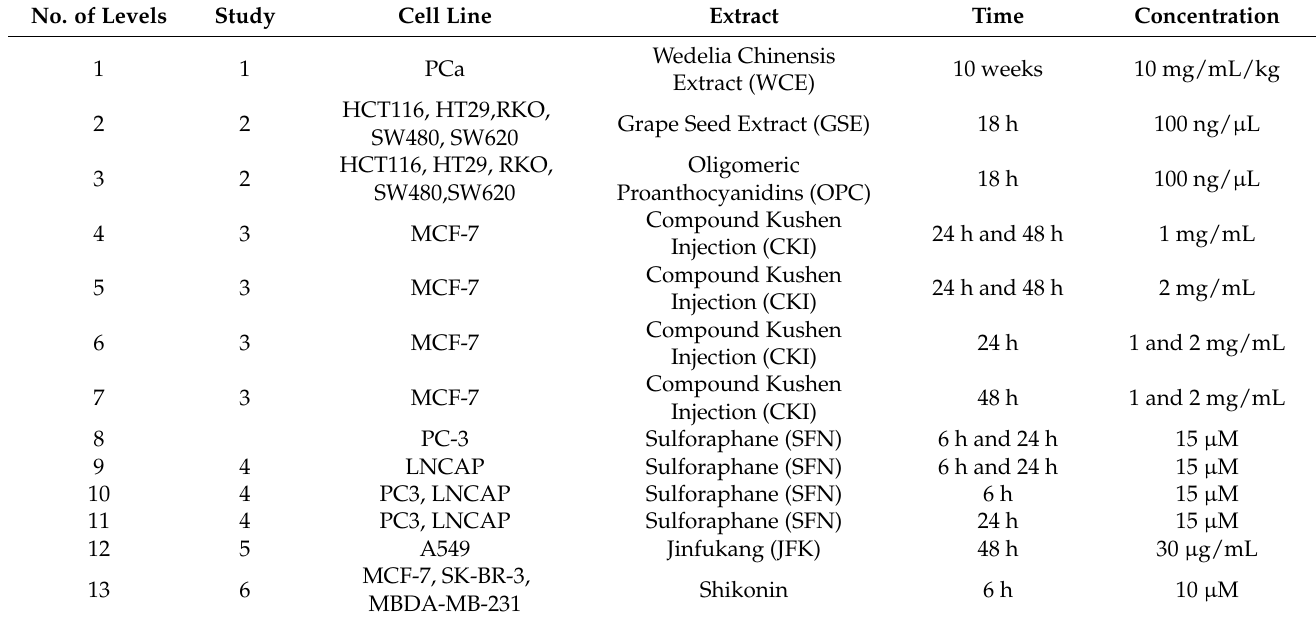
Table 2. Six studies were divided into 13 different